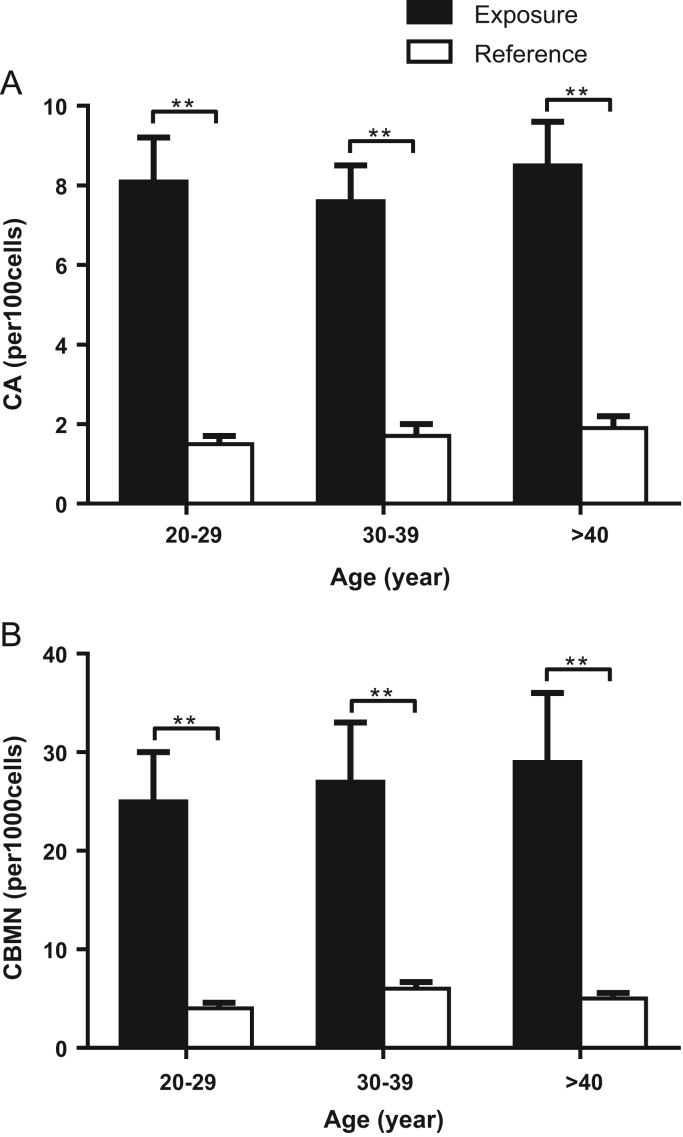
CA (A) and CBMN (B) in lymphocytes of workers recycling e-wastes and in reference group for different age sub-groups. A-B: CA and CBMN in lymphocytes between the group of workers recycling e-wastes and reference group for the sub-groups divided by age. There is no difference of CA and CBMN among the age sub-groups. **: P < 0.01. Two way ANOVA was also used to test the interactions between age and CA, CBMN in lymphocytes, respectively. (CA: F = 2.03, P = 0.18; CBMN: F = 1.07, P = 0.39).